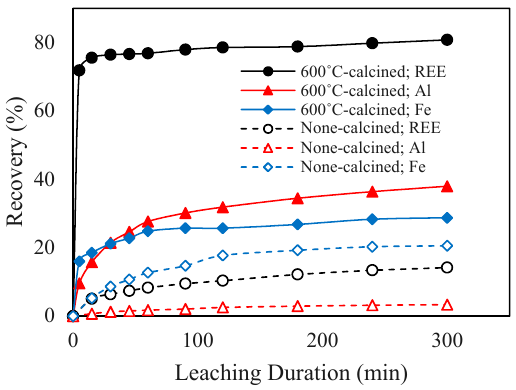
Figure 2. Effects of calcination on the leaching kinetics of REEs, Al, and Fe from Pocahontas No. 3 coarse refuse. (Data were extracted from [21]) .